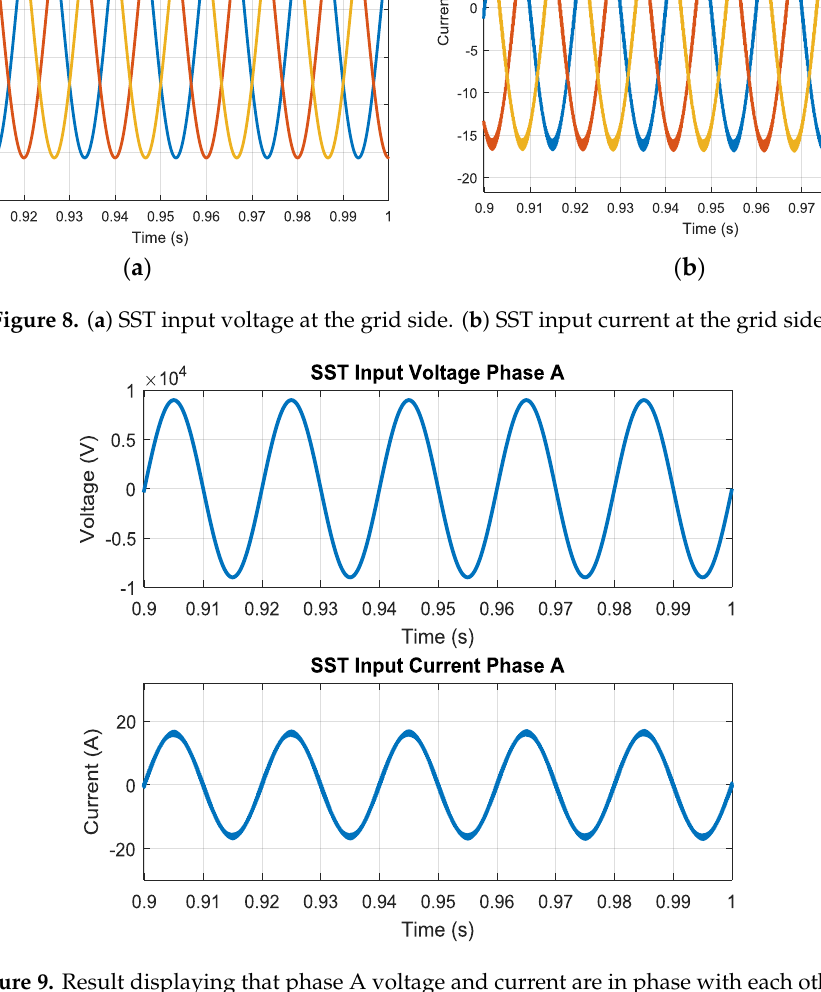
Figure 11. SST-VSC voltage and current at the DC -link. Figure 12. Primary and secondary voltage of the high frequency transformer.